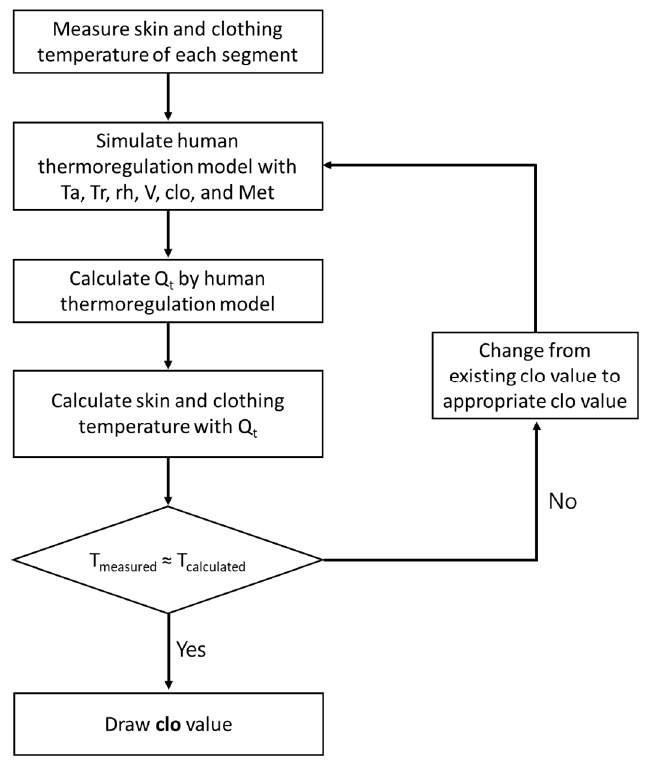
Figure 2. Flowchart of the evaluation of the clothing thermal insulation (clo level) using the human thermoregulation model.